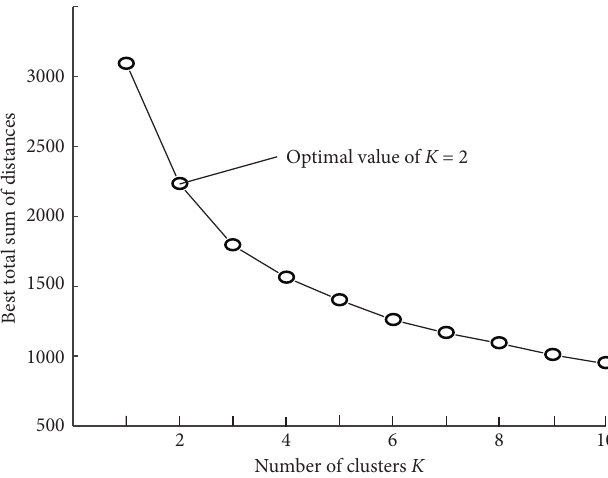
Figure 2: Elbow method for optimal value of k-clusters.